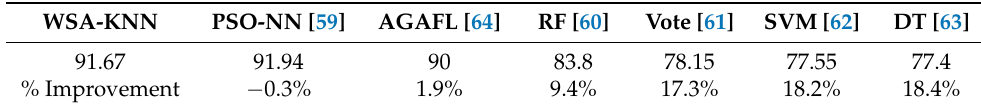
Table 11. Comparison of accuracy of various algorithms on Heart